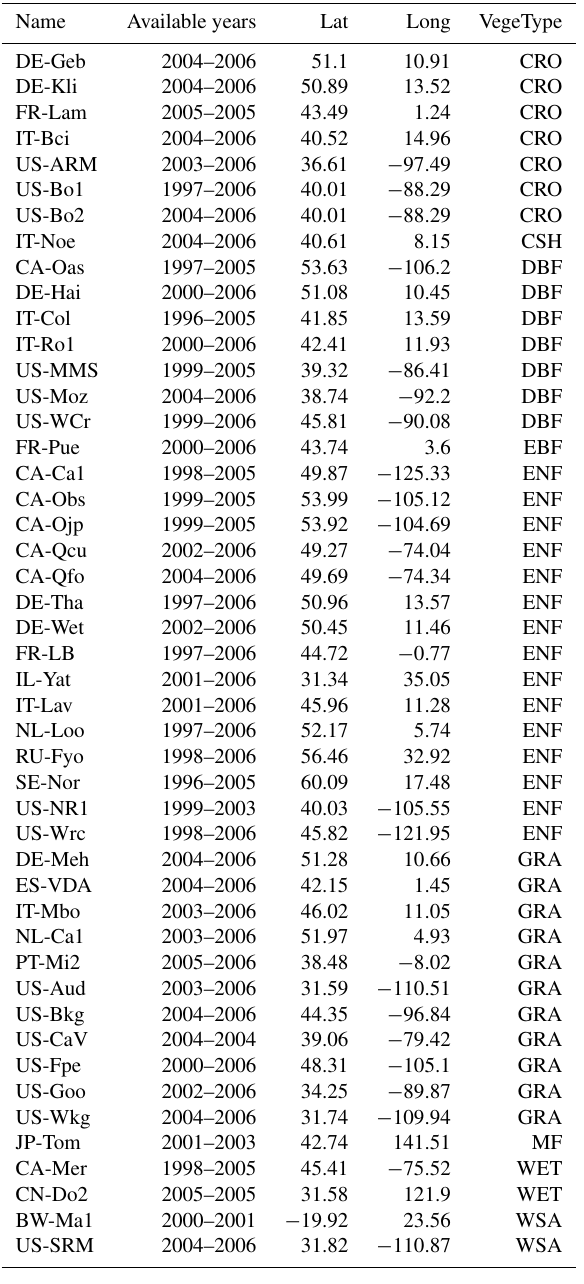
Table 5. Flux tower information list. From left to right: the station name, available data time span, latitude, longitude, and IGBP land cover type (Loveland et al.,